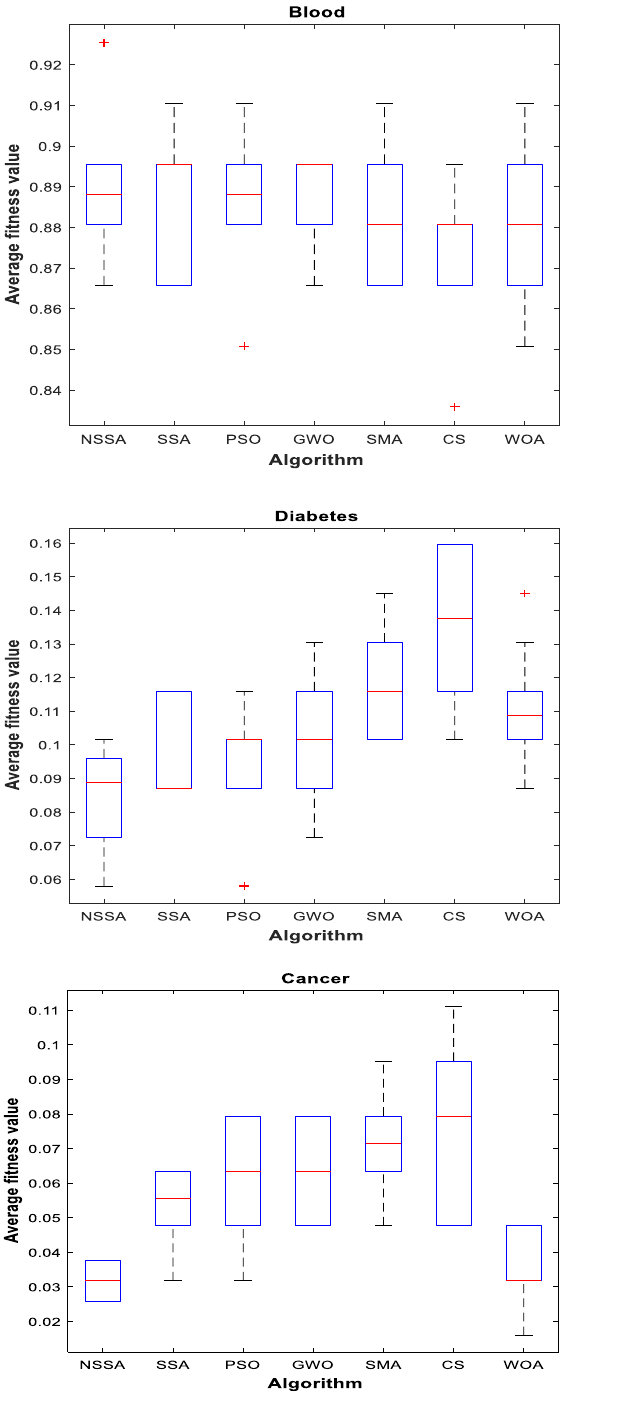
Fig. 4 Variance diagram during classification